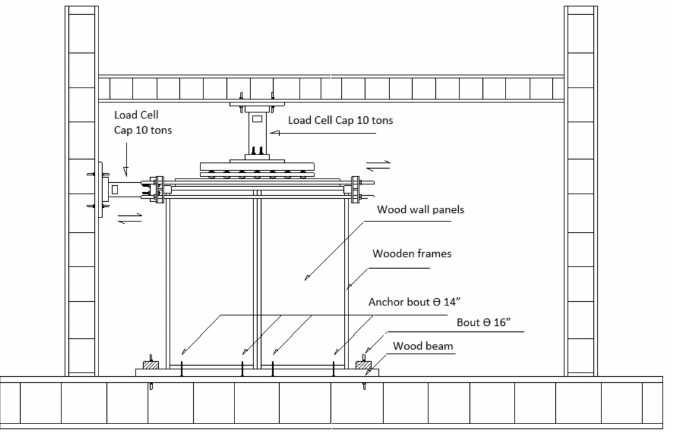
Figure 7. Shear wall panel testing settings.